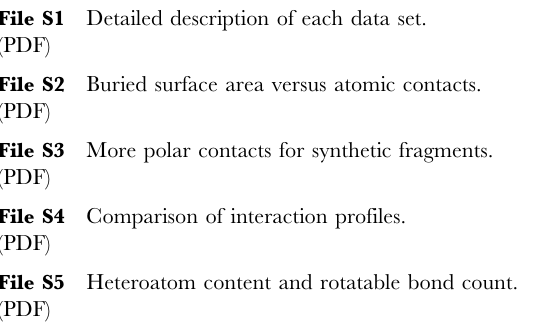
Figure S2 Comparisons of residue propensities at the binding sites for small molecule protein-protein inhibitors versus protein- protein complexes inhibited by them. (PDF) File S1 Detailed description of each data set. (PDF) File S2 Buried surface area versus atomic contacts. (PDF) File S3 More polar contacts for synthetic fragments. (PDF) File S4 Comparison of interaction profiles. (PDF) File S5 Heteroatom content and rotatable bond count. (PDF) File S6 Free energy of ligand binding versus the polar ratio of contacts [polar/(polar + apolar)] for the synthetic small molecules set and the small peptide set. (PDF) File S7 Free energy of ligand binding versus the number of atoms of the ligand for the synthetic small molecules set and the small peptide set. (PDF) File S8 Protein-protein complexes inhibited by small molecules. (PDF) Table S1 Approved and oral small molecule drugs that engage more than 40% polar contacts with their bound protein. Table S2 Number of entries in each set of molecules.